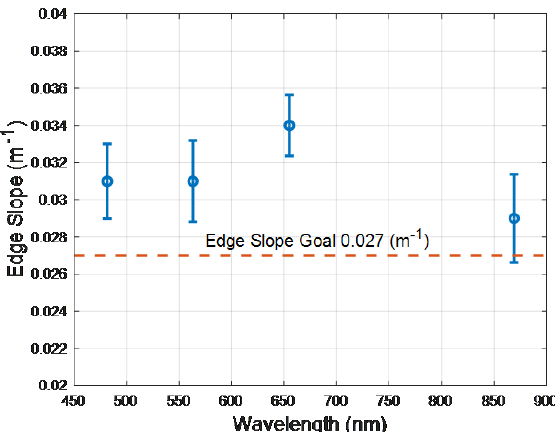
Figure 22. DESIS in flight Edge Slope in the cross-track direction. Values plotted are means and standard errors of 30 in-scene edges.